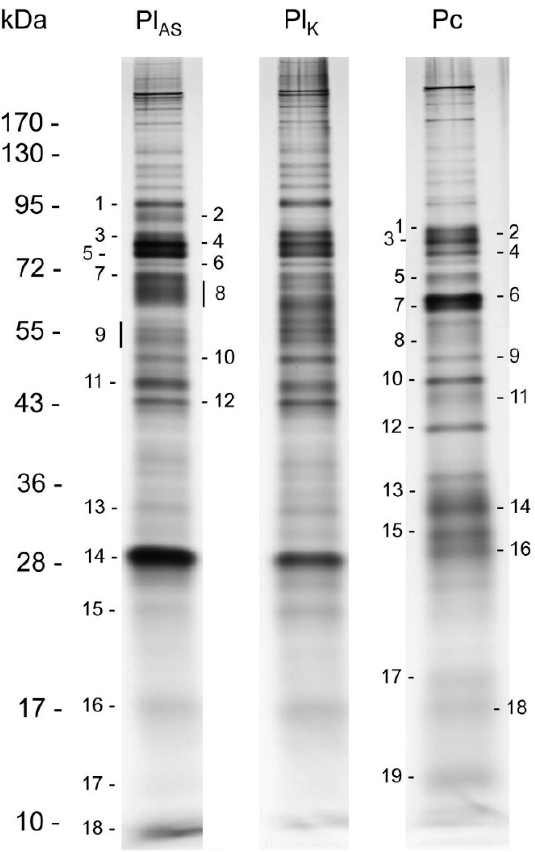
Figure 15. 1D SDS-PAGE separation of P. lounsburyi (Pl AS and Pl K strains from Kenya and South Africa, respectively) and P. concolor venom proteins under reducing conditions and silver staining. Stained protein bands (numbered) excised and submitted for protein identification by LC-MS-MS. (Source: from [55] reproduced under the terms of Creative Commons Attribution Licence CC-BY 4.0 via Scientific Reports ). Table 8. Putative Psyttalia venom proteins with putative functions or present in both species; ranked based on Reads Per Kilobase of transcript, per Million mapped reads (RPKM) values for P. lounsburyi , and showing their occurrence in other parasitoid wasps. Braconidae matches are in bold. (Source: data combined from Tables 1 and 2 in [55]). RPKM (Rank) Proteins Found in other Parasitoid Wasp Venoms (Braco- Putative Function P. louns- nids Highlighted) * buryi